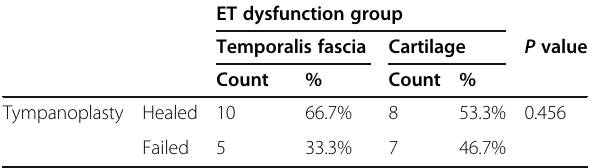
Table 2 Comparison between the tympanoplasty results using temporalis fascia graft and cartilage graft in the normal ET function group Normal ET function group Temporalis fascia Cartilage p value Count %